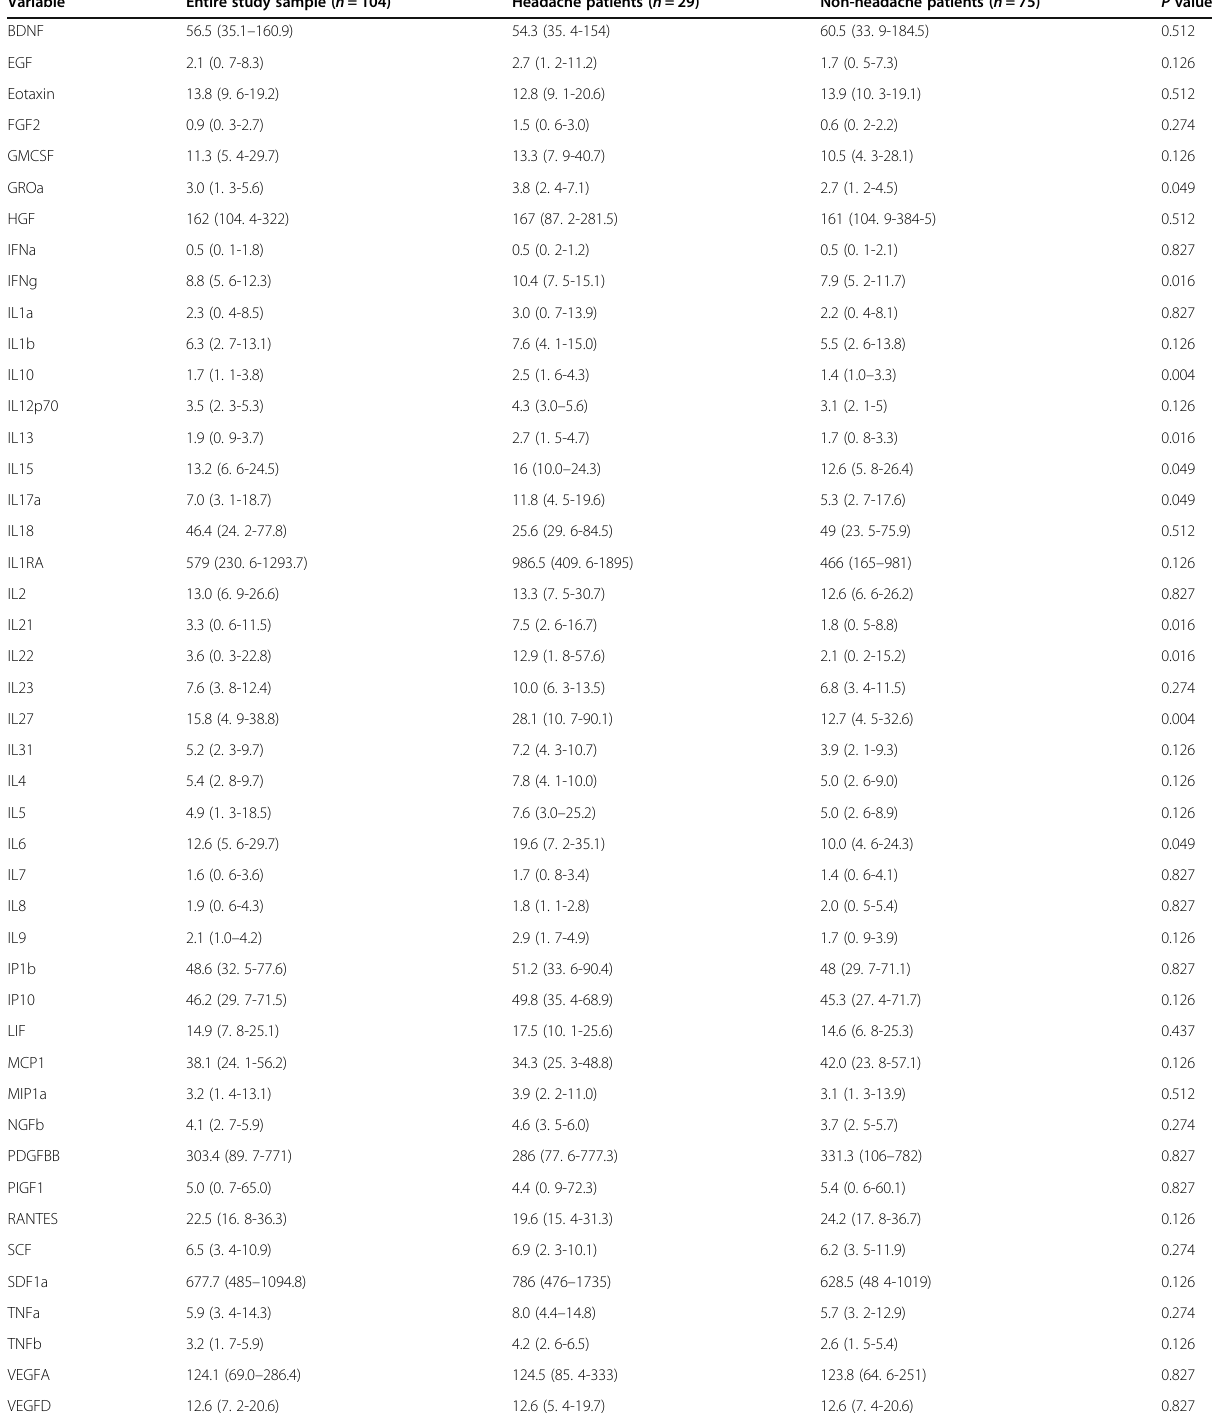
Table 2 comparison of the crude median values of